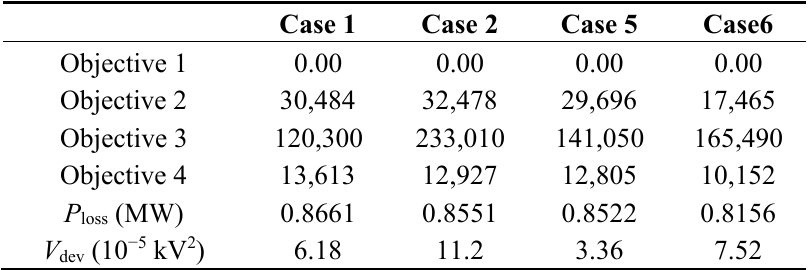
Table 3. Index comparison of BESS and EV